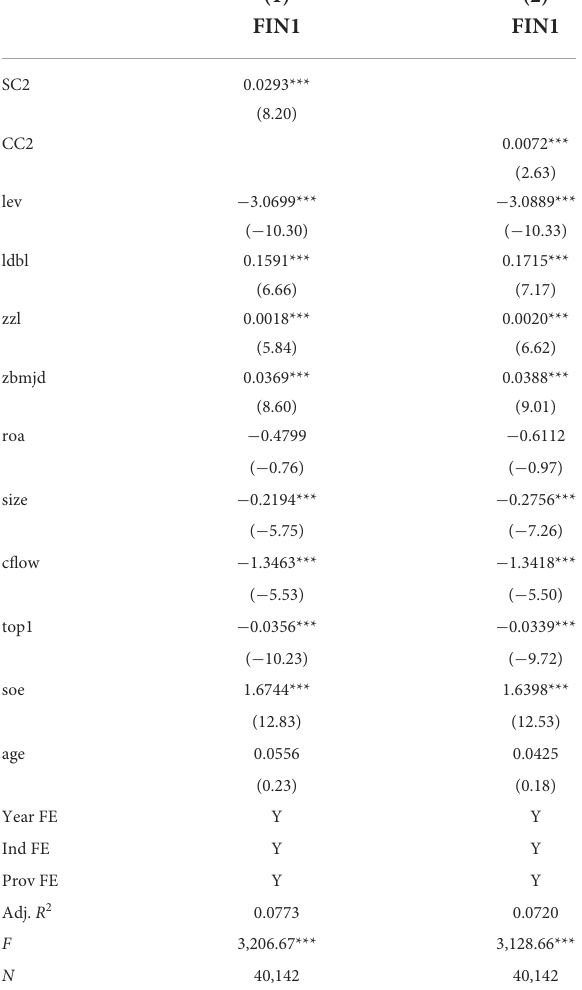
TABLE 7 Instrumental variable